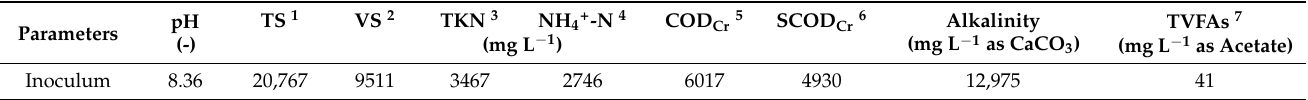
Table 2. Chemical composition of